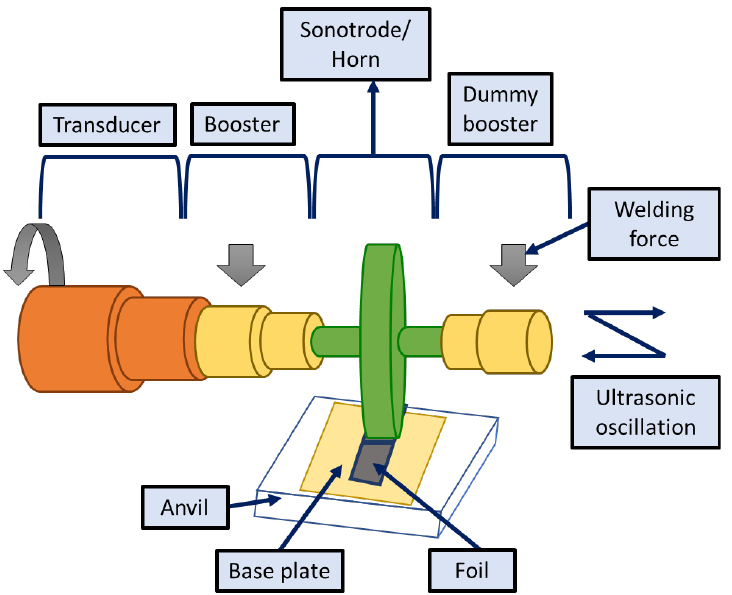
Figure 14 . Ultrasonic additive stage illustrating the different components